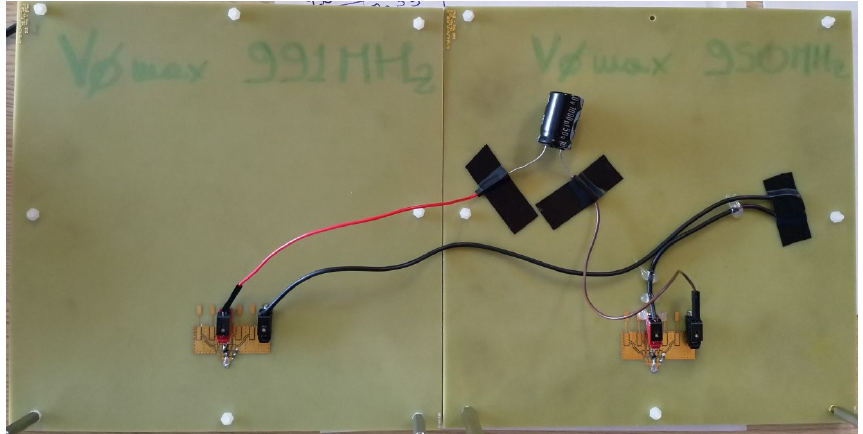
Figure 10. Back side circuitry of the WPT system: a series of two rectennas are connected to a capacitive load C L of 1000 µ F to store the converted energy from RF.